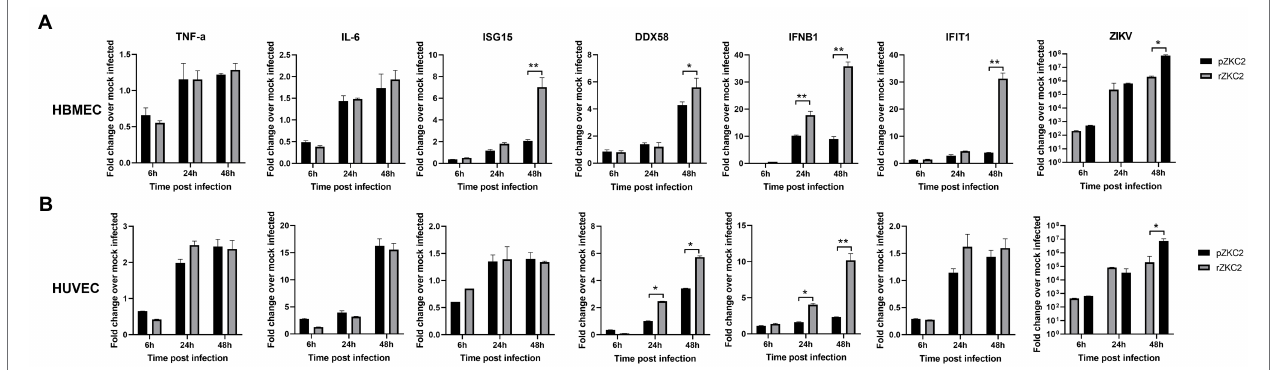
FIGURE 7 | The immune response of rZKC2 and pZKC2 in HBMEC and HUVEC. (A) Fold change in transcript levels of the TNF- α , IL-6, ISG15, DDX58, IFNB1, IFIT1 and ZIKV viral RNA (NS5 gene) in HBMEC cells at different time points post-infection relative to mock-infected control. (B) Fold change in transcript levels of the same genes in HUVEC cells at different time points post-infection relative to mock-infected control. The values are representative of three repeat experiments. * p < 0.05, ** p <